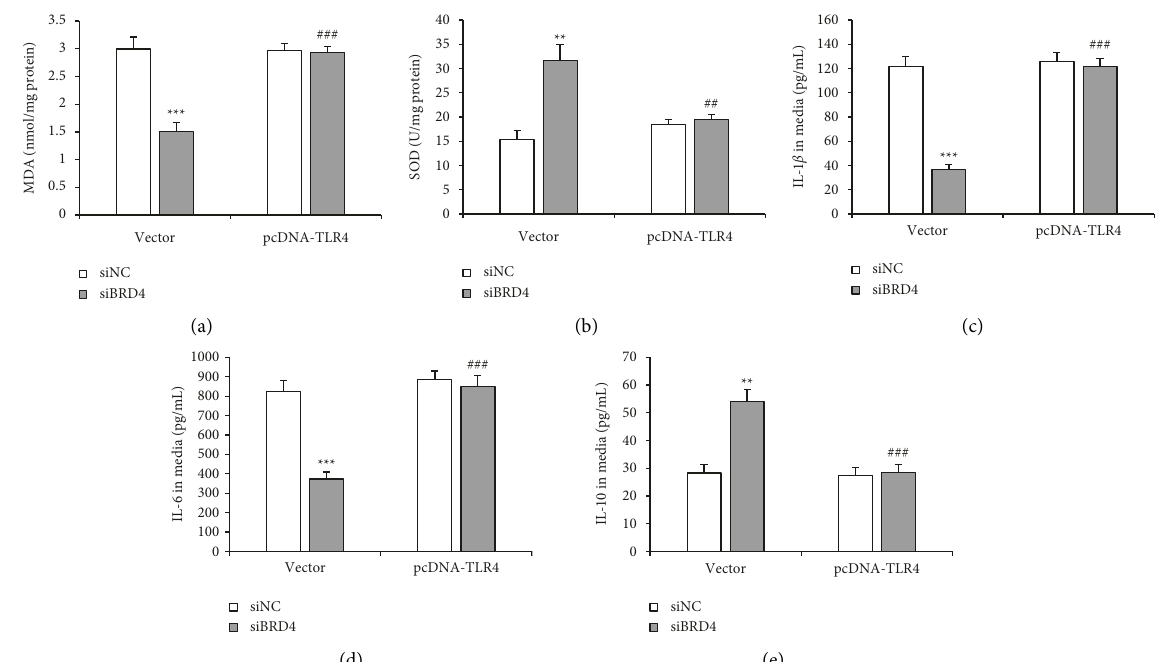
Figure 7: Overexpression of TLR4 attenuates the siBRD4-induced inhibition on oxidative stress and inflammatory cytokine. Ang II- induced cells were used as a control. Respective commercial kits examined the MDA level (a) and SOD activity (b) in cells of siBRD4 and/or pcDNA-TLR4. ELISA measured the secreted IL-1 β (c), IL-6 (d), and IL-10 (e) in the cell supernatant. Each experiment was performed in triplicate and repeated at least three times. ∗∗ P < 0 . 01, ∗∗∗ P < 0 . 001 vs. vector+siNC group; ## P < 0 . 01, ### P < 0 . 001 vs. vector+ siBRD4